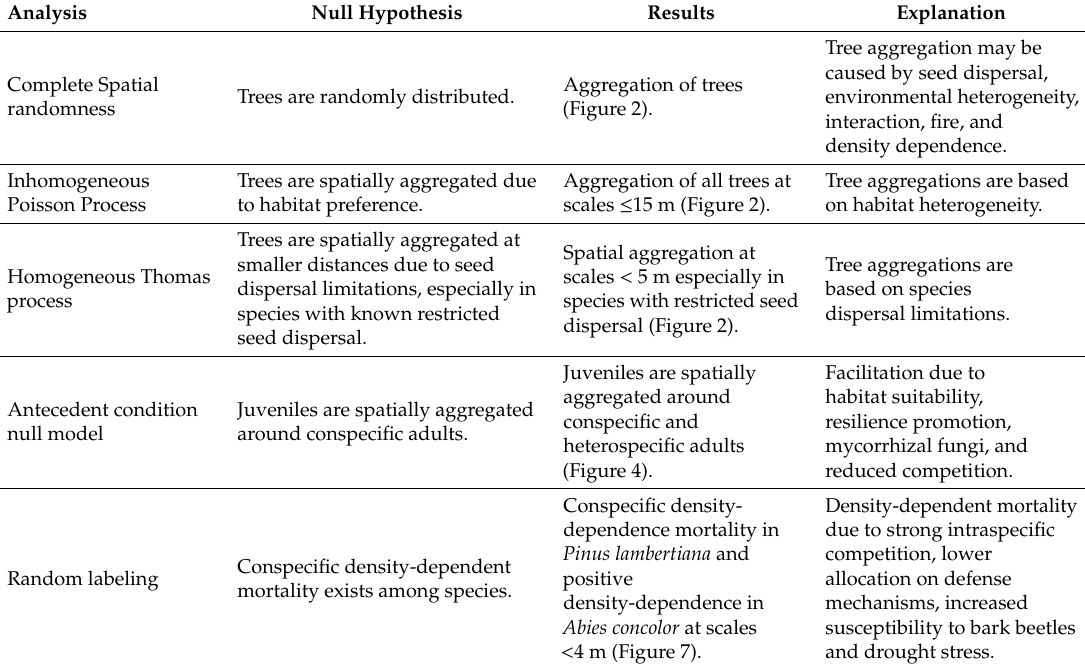
Table 1. Overview of null models, their results, and explanations used to investigate the spatial structure of dominant tree species in the Yosemite Forest Dynamic